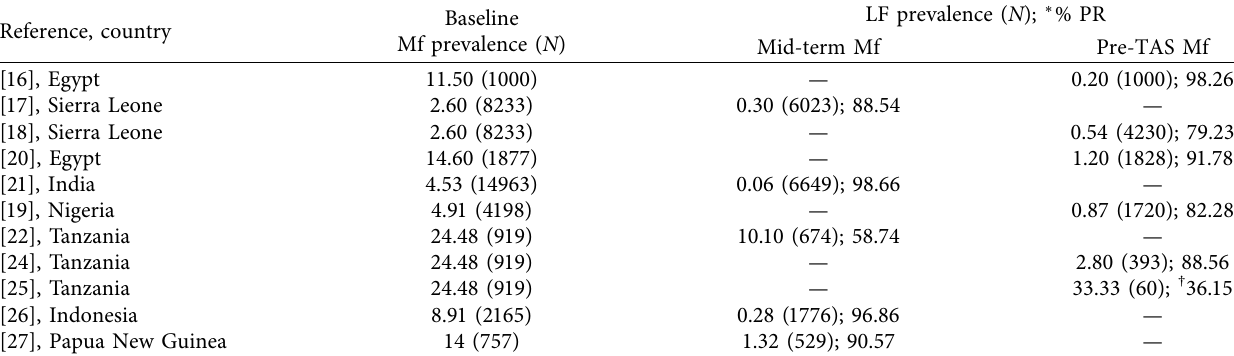
Table 3: Percentage microflaria prevalence reduction at mid-term and pretransmission assessment survey (pre-TAS) compared to baseline prevalence in LF mass drug administration. Reference, country